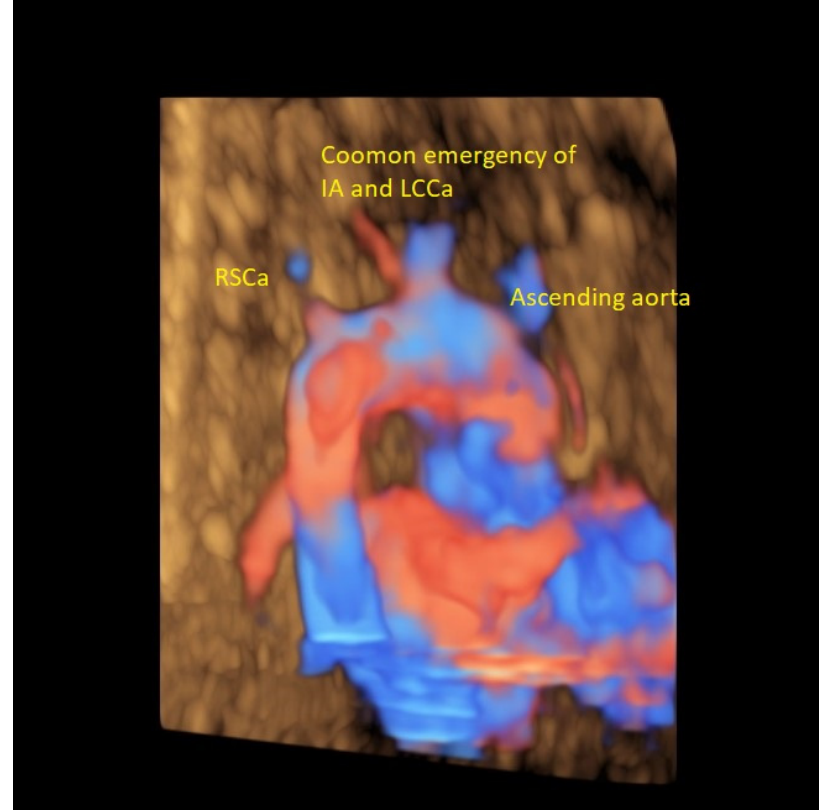
Figure 6. 3D color image rendering of a AAAV type B.